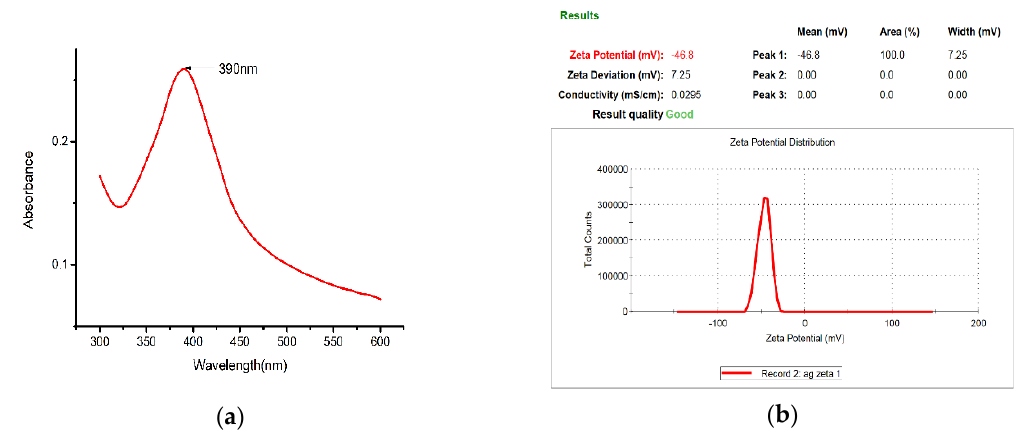
Figure 11. Nano-Ag colloid analysis results for ( a ) UV-Vis and ( b ) zeta potential.